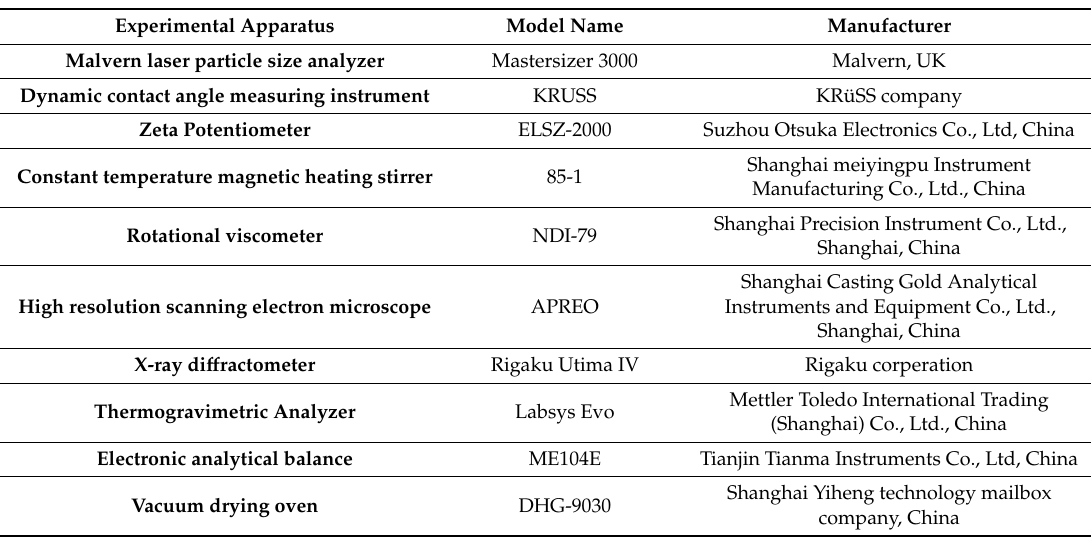
Table 2. Main experimental instruments and